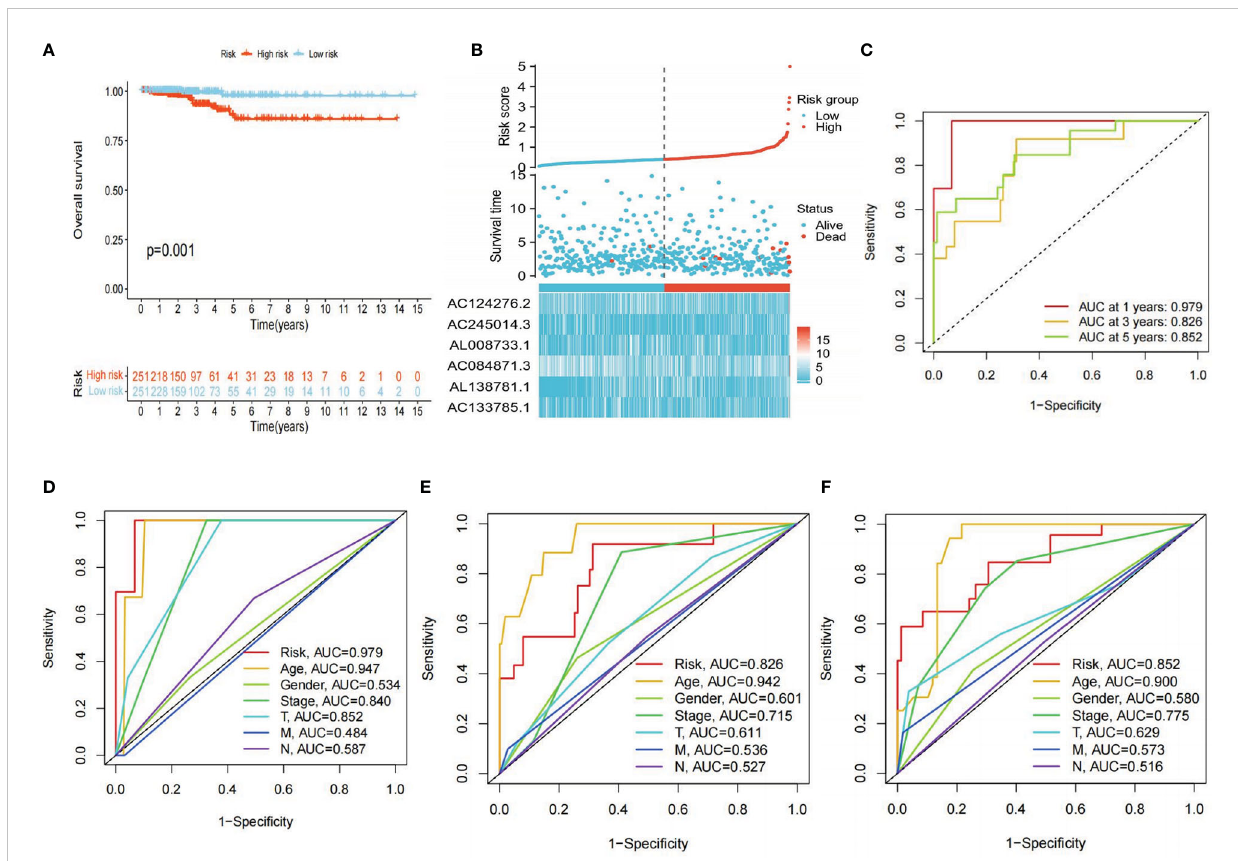
FIGURE 5 Clinical correlation analysis. (A) Differences in OS between high- and low-risk groups (P<0.05 was considered signi fi cant). (B) Clinical-prognostic-risk factor plots for high- and low-risk groups in the TCGA-THCA cohort. (C) AUC values for high- and low-risk groups in the TCGA-THCA cohort at 1, 3, and 5 years, respectively. (D-F) The 1, 3, and 5 years ROC curves of each clinical trait in the TCGA